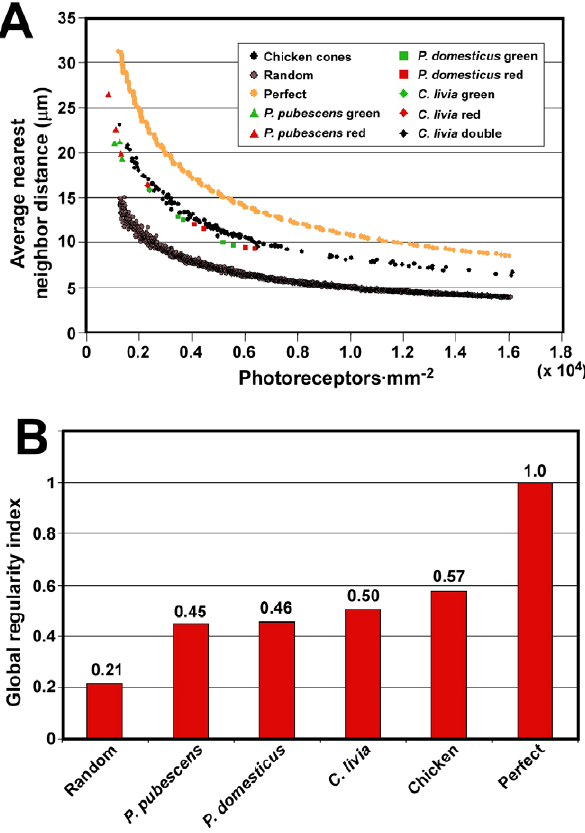
Figure 7. A range of bird species show similar cone patterning. (A) Graph of photoreceptor density vs. average nearest neighbor distance for three additional species of bird representing three different orders. All P15 chicken datapoints are shown in black for clarity. P. pubescens , Picoides pubescens ; P. domesticus , Passer domesticus ; C. livia , Columba livia . (B) Graph of the global regularity indices for all four bird species examined as well as for computer-generated random and perfect distributions. The global regularity index is the inverse of the slope of the best fit linear curves of the form, y = mx, for each of the datasets as shown in Figure S3. All values are normalized to that for perfect which is set equal to one.